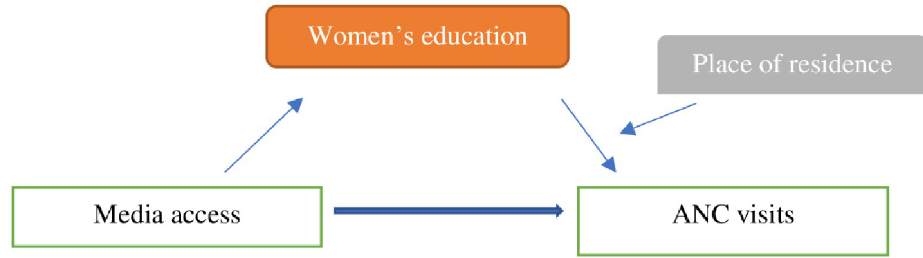
Fig 3. Moderated mediation model.